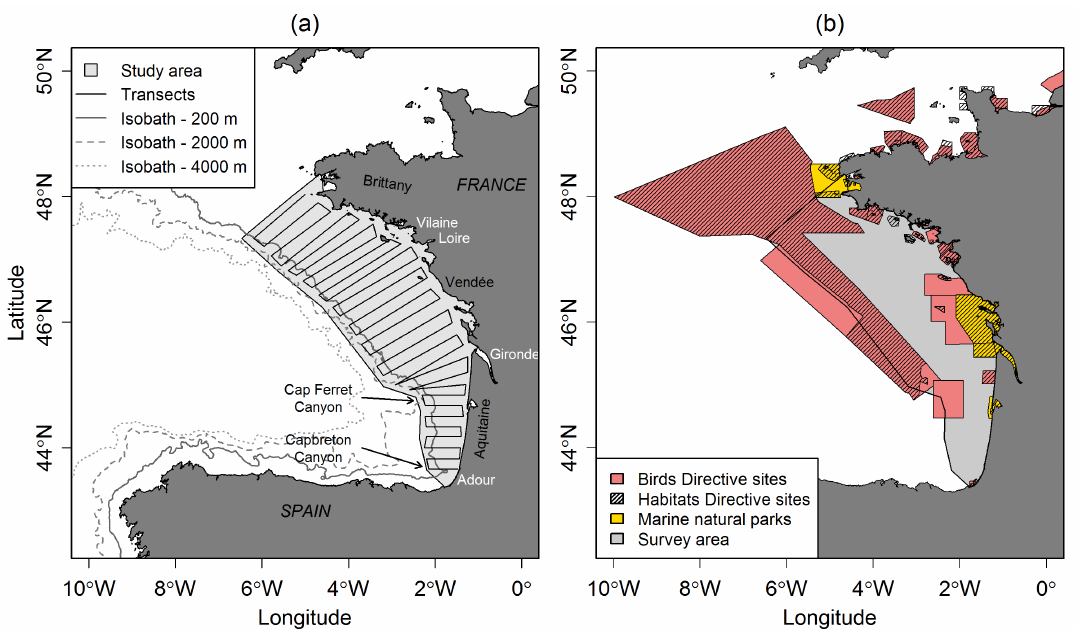
Figure 1 – (a) Study area and theoretical sampling design of PELGAS survey. Names of four main estuaries in white, names of other geographical localities and main canyons in black; (b) French Marine Protected Areas (MPAs) in the Bay of Biscay and English Channel. This study considered only sites overlapping the survey area. Birds Directive sites were assessed only for seabirds, Habitats Directive sites only for